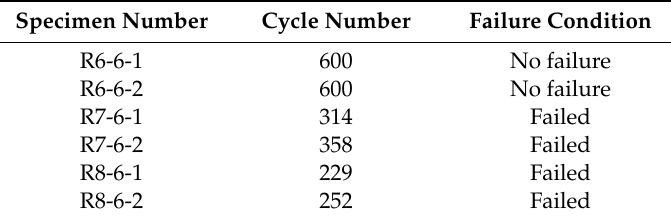
Table 4. Test results of the rock specimen after cycling for 600